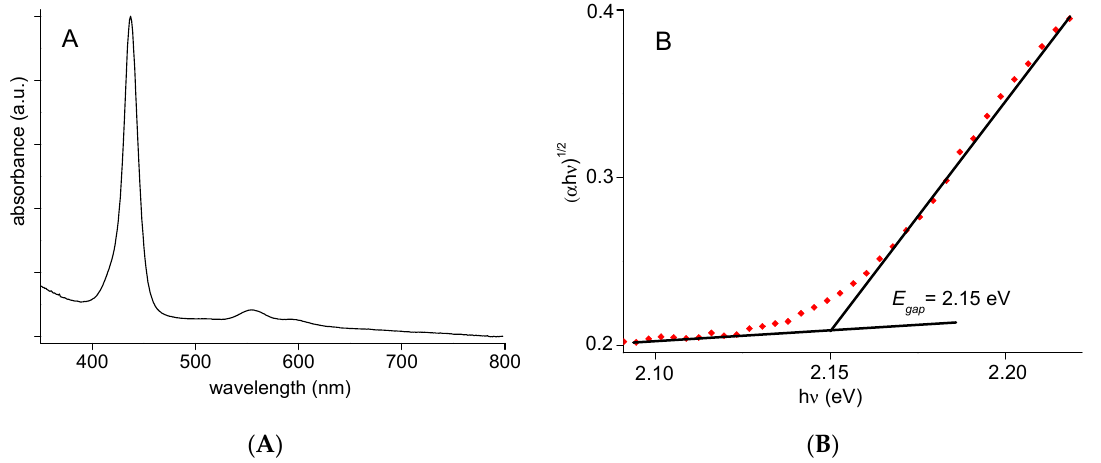
Figure 1. UV/vis absorption spectrum of [Co(TMFPP)] in CH 2 Cl 2 (A); curve of ( α h υ ) 2 as a function of photon energy E (B).